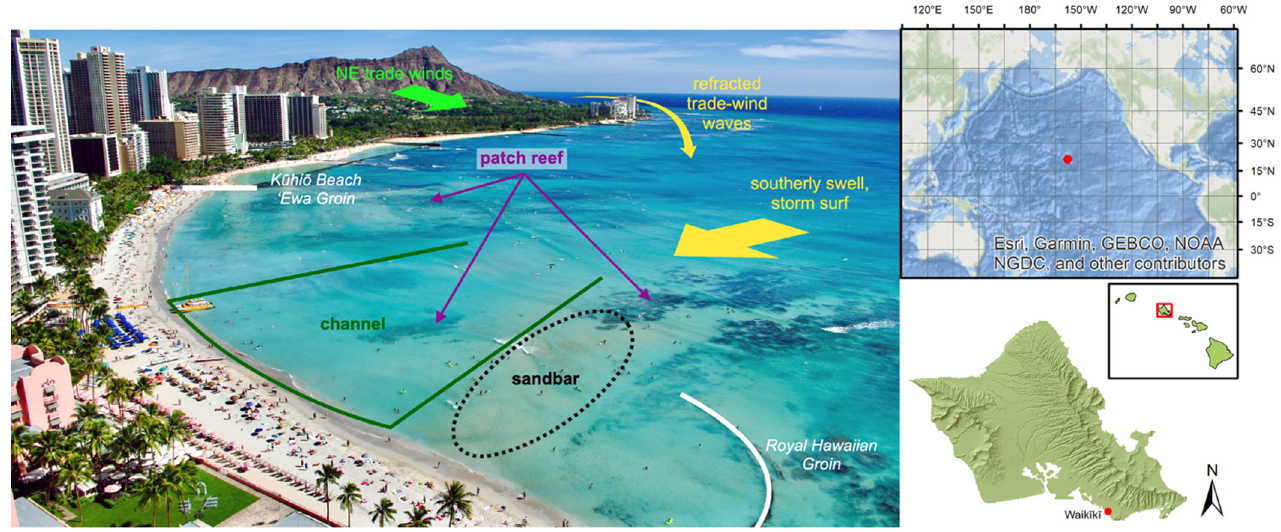
Figure 1. Looking southeast above the Royal Hawaiian Beach. A crescent-shaped, carbonate sand beach located in the heart of Waik¯ık¯ı on the south shore of O‘ahu. It is a compartmentalized littoral cell, with terminal structures (K¯uhi¯o Groin and Royal Hawaiian Groin) preventing significant longshore transport into or out of the cell. The nearshore is complex, with patch reefs, a shallow submarine channel, and a perennial sandbar adjacent to it. These features interact with wind-generated waves produced by persistent northeasterly trade winds in addition to southerly swell during the summer months and storm surf, typically during hurricane season (June–November).